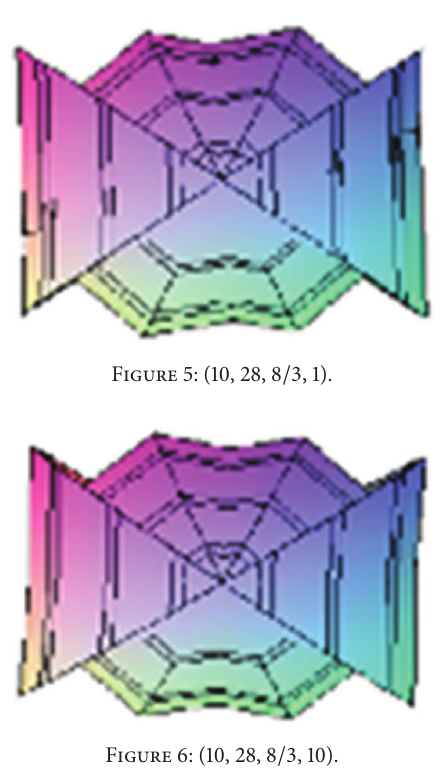
Figure 4: (10, 28, 8/3 , 0).